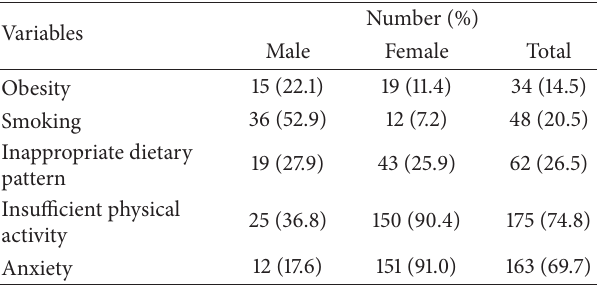
Table 5: Knowledge of the studied type 2 diabetic patients about complications of the disease and their insight towards their quality of